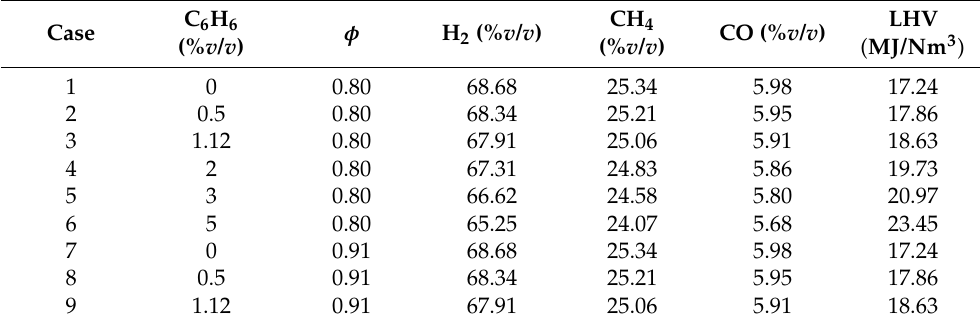
Table 2. Operating conditions of the experimental investigation of H 2 /CH 4 /CO fuel mixtures, with different levels of C 6 H 6 (% v / v ) doping and equivalence